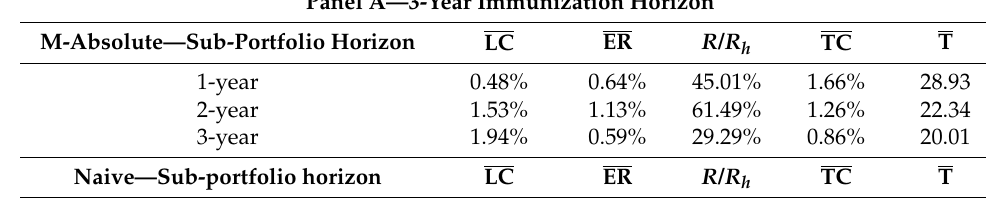
Table 1. U.S. Treasuries Immunization